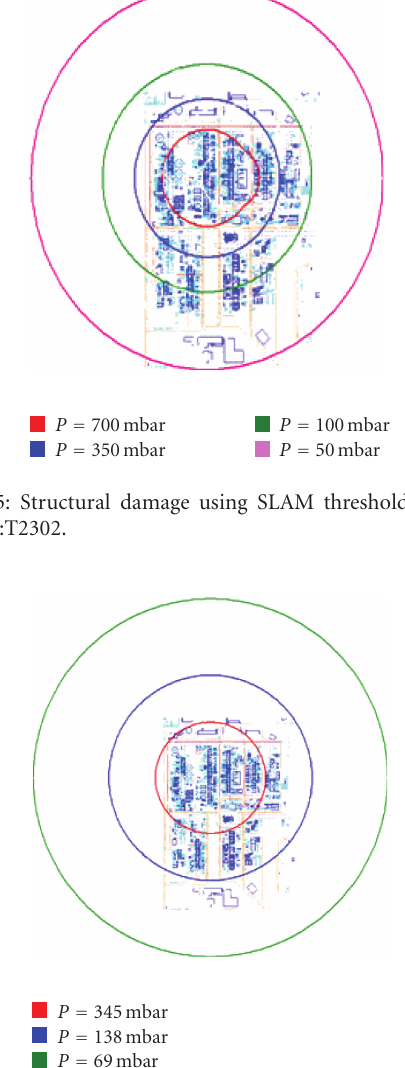
Figure 13: Explosive mass T2302.